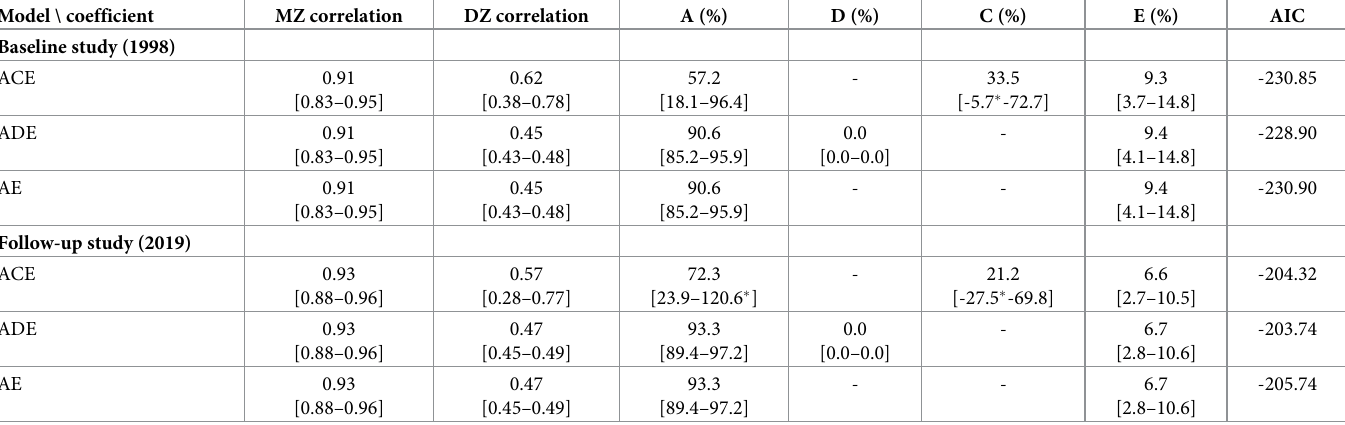
Table 3. Broad-sense heritability analysis of lens fluorescence adjusted for age and smoking (n = 118). Model \